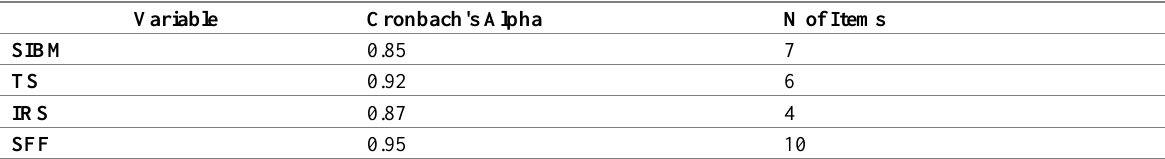
Table 1: Reliability results